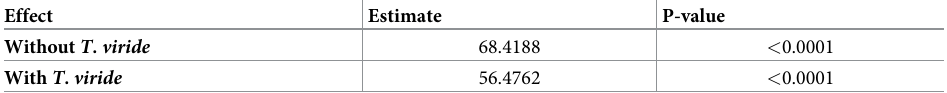
Means that do not share the same letter are significantly different at P < 0.05. ND, data were not detected; n = 3 per experimental replicate. A1, B1 are 80%vermicast+20%sawdust; A2, B2 are 60%vermicast+40%sawdust; A3, B3 are 40%vermicast+60%sawdust; A4, B4 are 20%vermicast+ 80%sawdust; and A5, B5 are sawdust alone. EC is electric conductivity; N is nitrogen; Ca, calcium; K is potassium; Mg is magnesium; P is phosphorus; Na is sodium; SO4 2- is sulphate; Cl - is chloride; and B is boron.